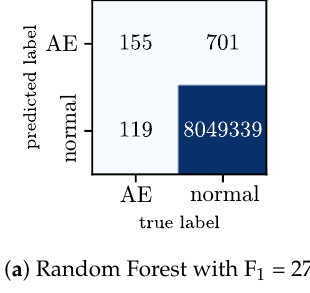
Figure 6. Confusion matrices of the two best models (#6, #16), see Table 3. Table 3. Results on test